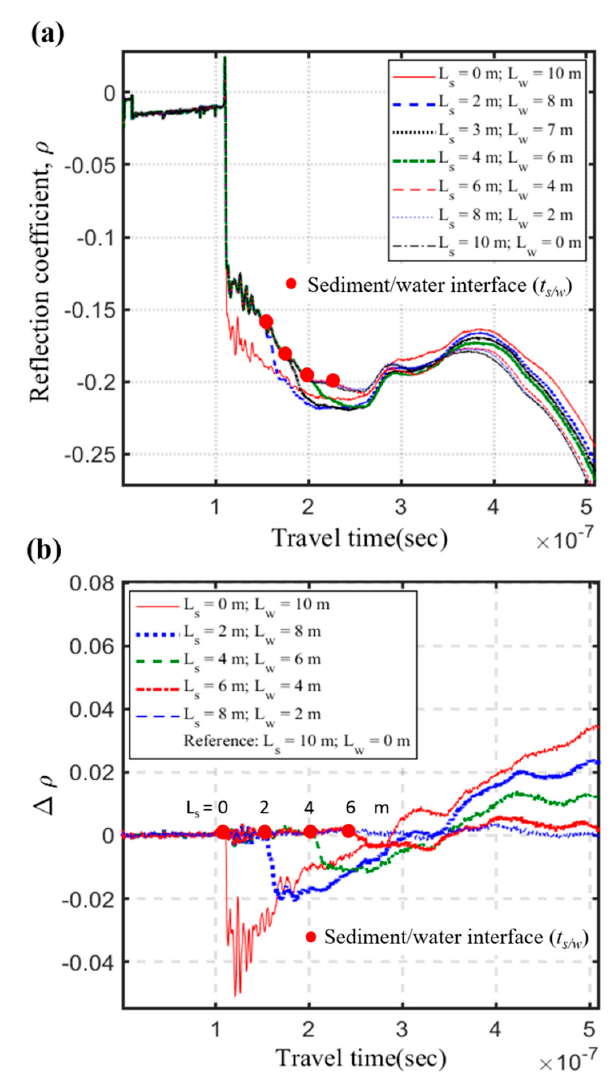
Figure 11. ( a ) Measured raw data of the full-scale scour simulation experiments for the intact TDR sensing cable, and ( b ) the differential waveforms using the case of L s = 10 m as the reference waveform.